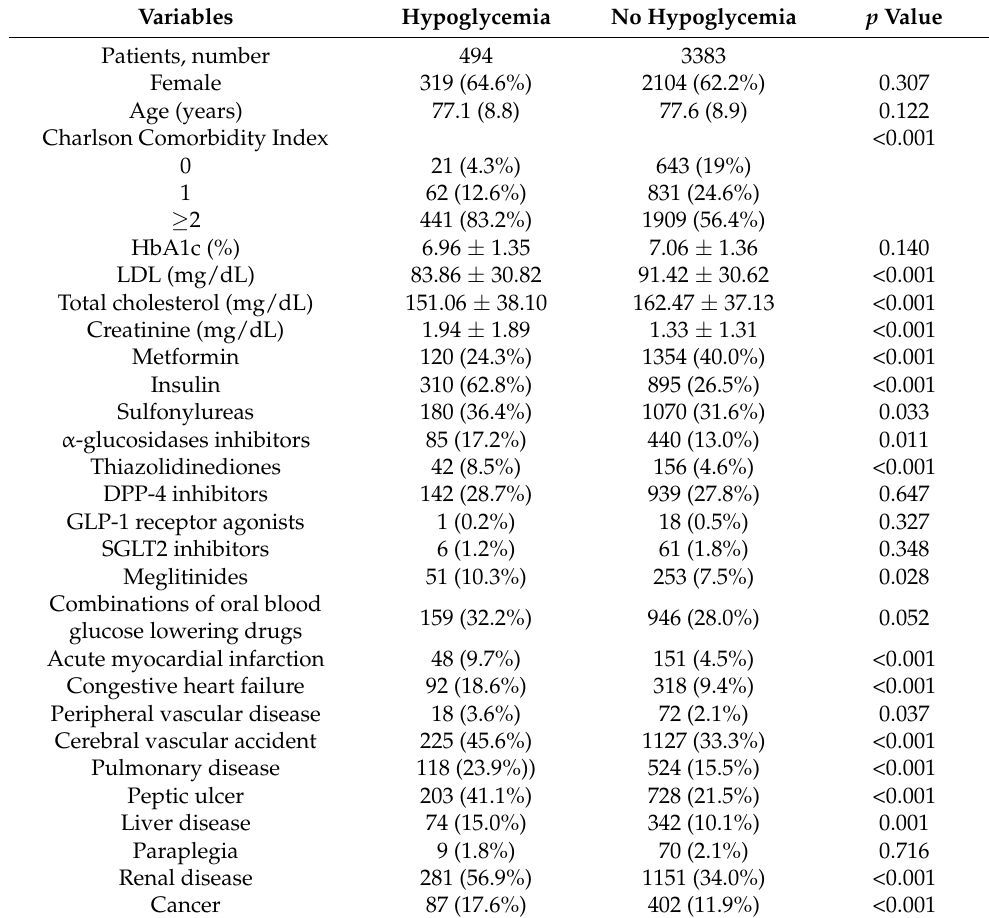
Table 2. The difference of clinical characteristics, antidiabetic medications, and comorbidities among patients with and without hypoglycemic